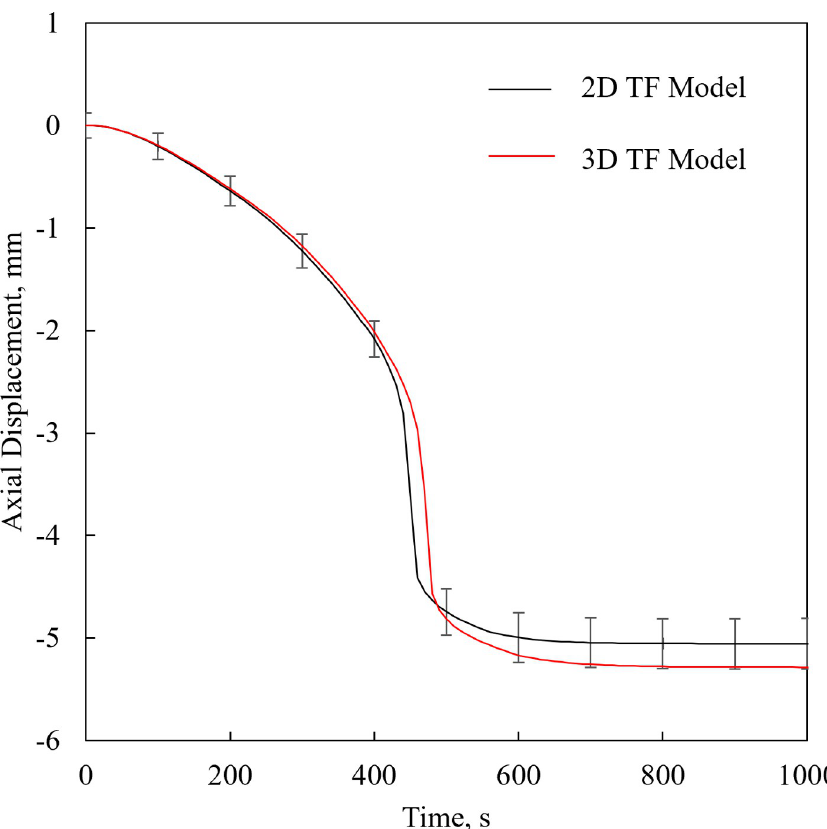
Fig 8. TF 2D vs 3D model. Comparison of displacement histories along the centerline of the container between the TF 2D and 3D models for a cooling rate of 20F0B0C/min. The error bars refer to the uncertainty in experimental measurements for reference, although the displayed results are of